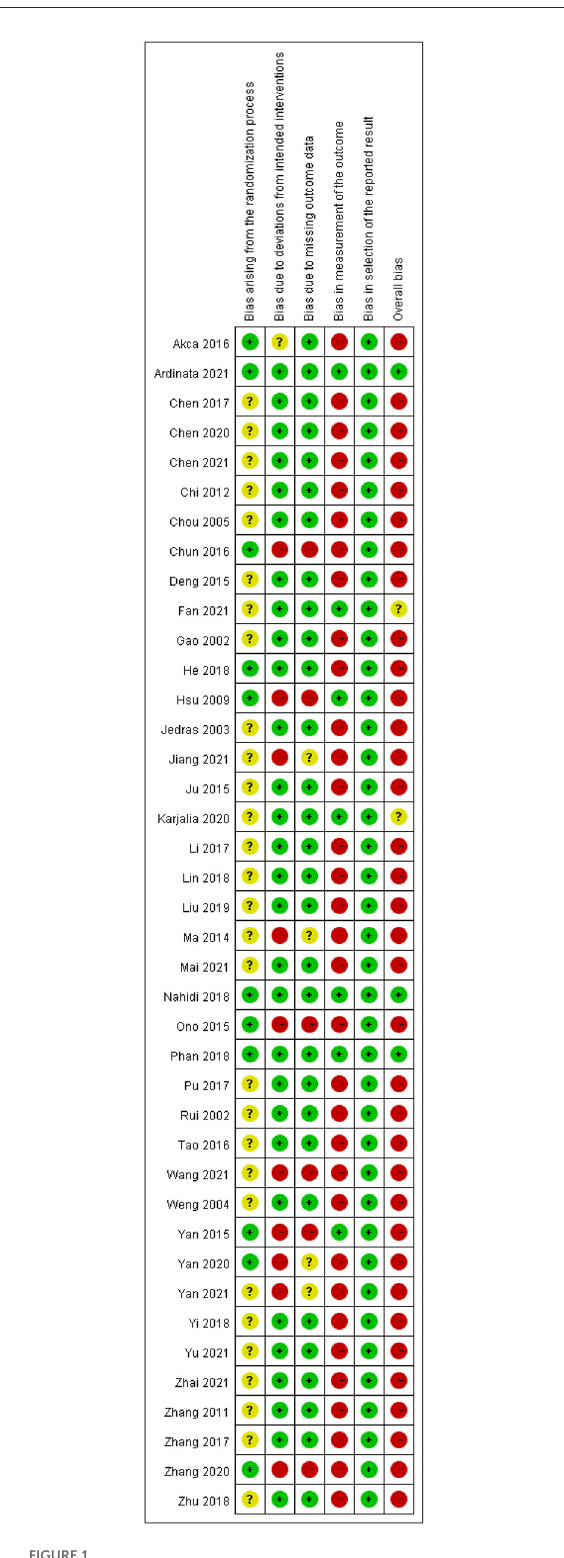
FIGURE1 Flowchart showing the selection process for the studies